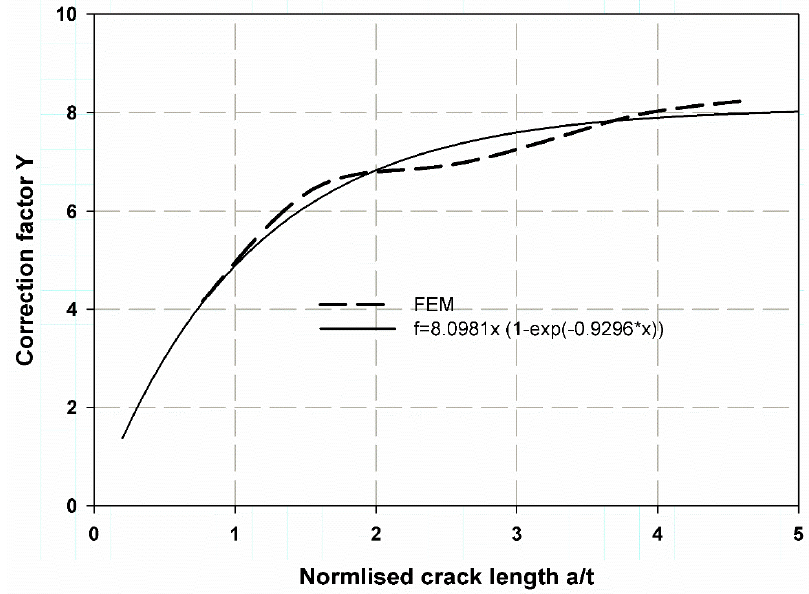
Figure 16. Correction factor for a movable crack through the thickness of the walled composite cylinder.